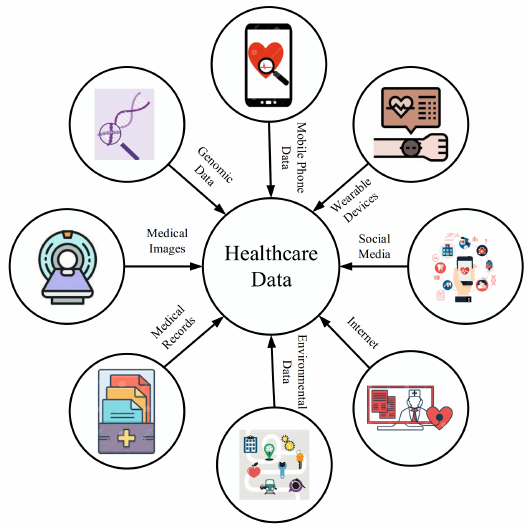
Figure 1. Different data generation sources in